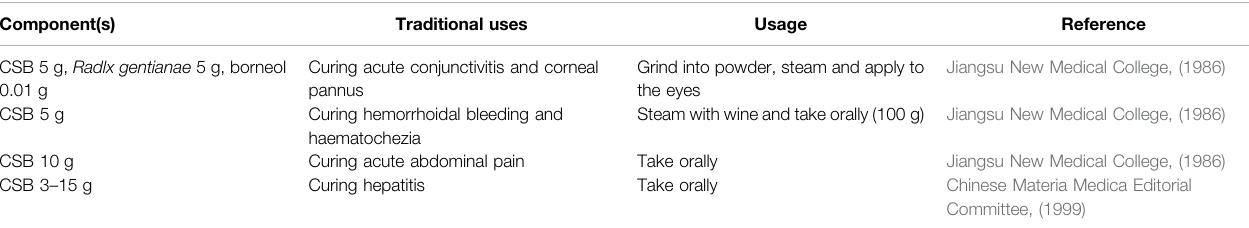
TABLE 4 | The application of